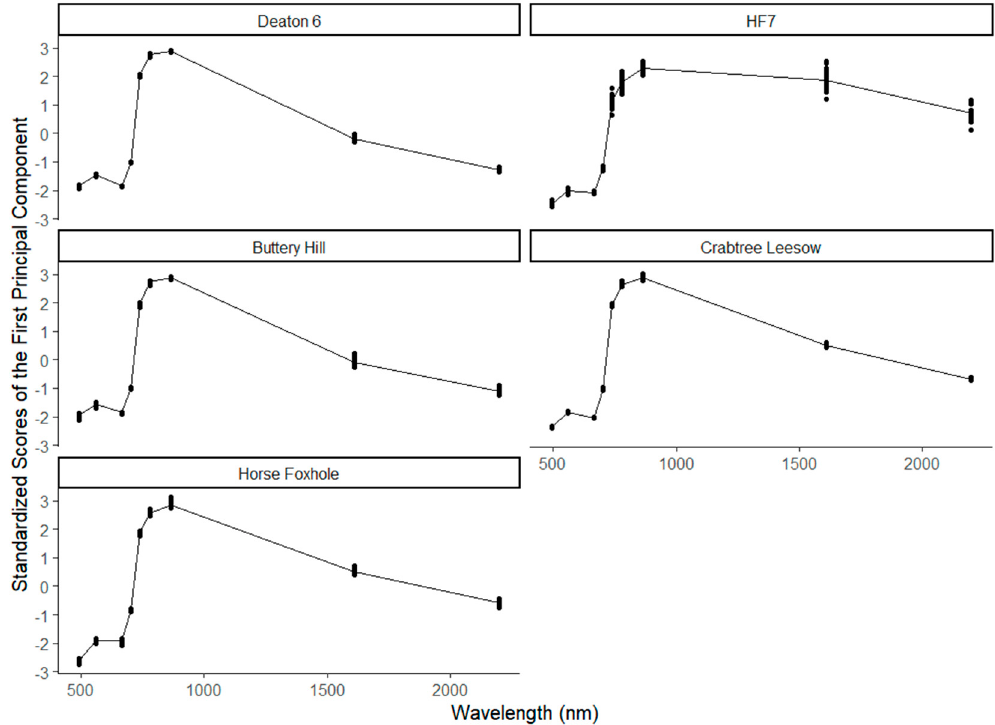
Figure 6. The spectral signature of the standardized first principal components of each Sentinel-2 waveband’s temporal variation in the potato canopies at 5 different study sites.